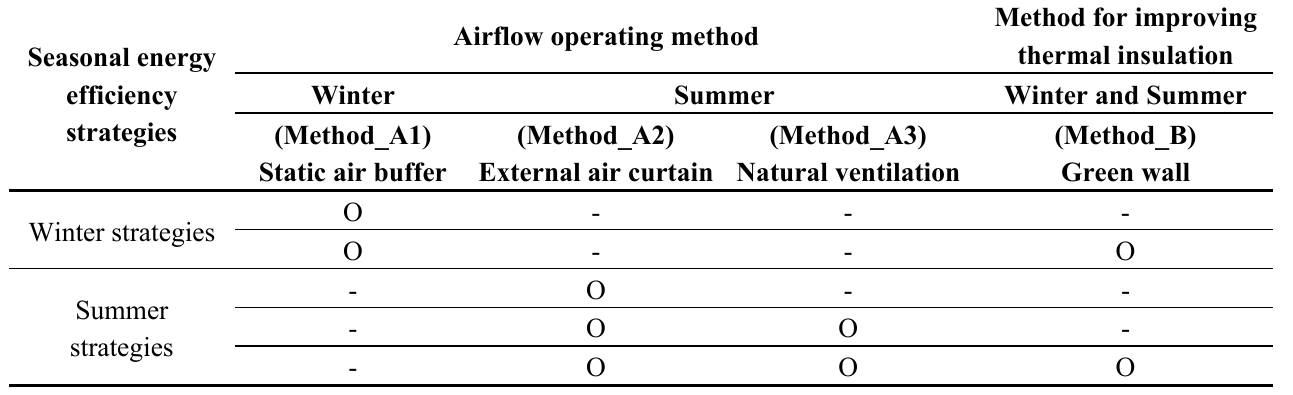
Table 3. Seasonal energy efficiency